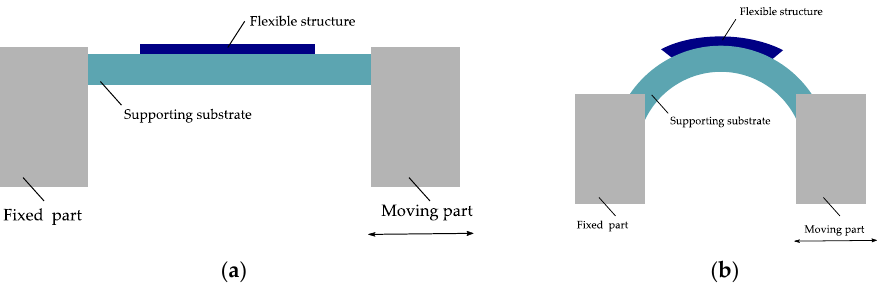
Figure 14. Schematic view of dynamic push to flex bending setup: ( a ) In a flat position and ( b ) under bending. Modified and freely sketched after [95,101].